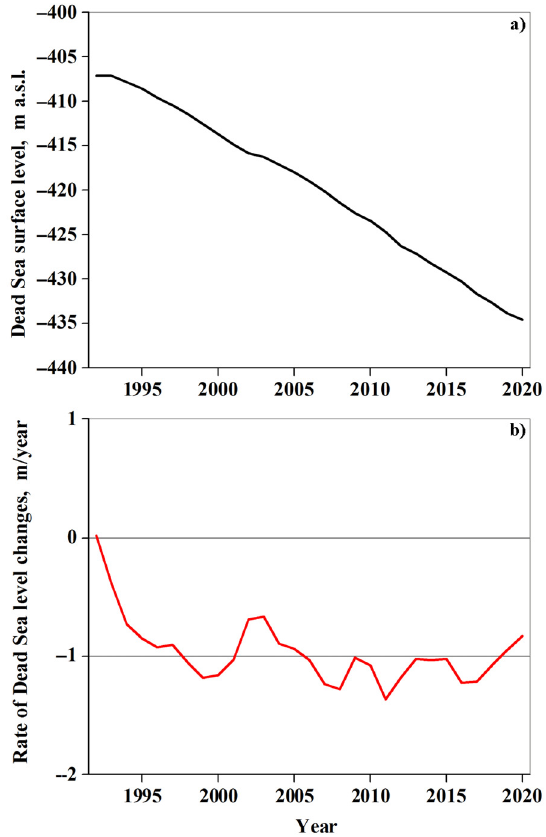
Figure 17. ( a ) Yearly data of Dead Sea water levels based on available measurements from 1992 to 2020; ( b ) the rate of Dead Sea water level drop from year to year.